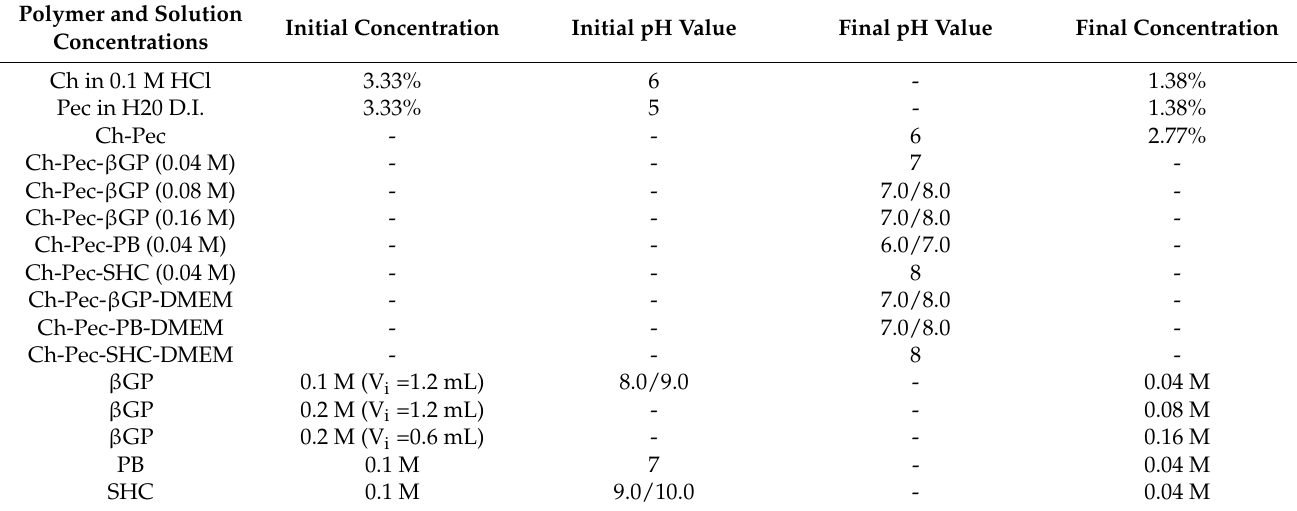
Table 1. Initial and final polymer and GA solution concentrations. pH values of Ch and Pec solutions, gelling agent, Ch-Pec mix and final hydrogels. V i = initial